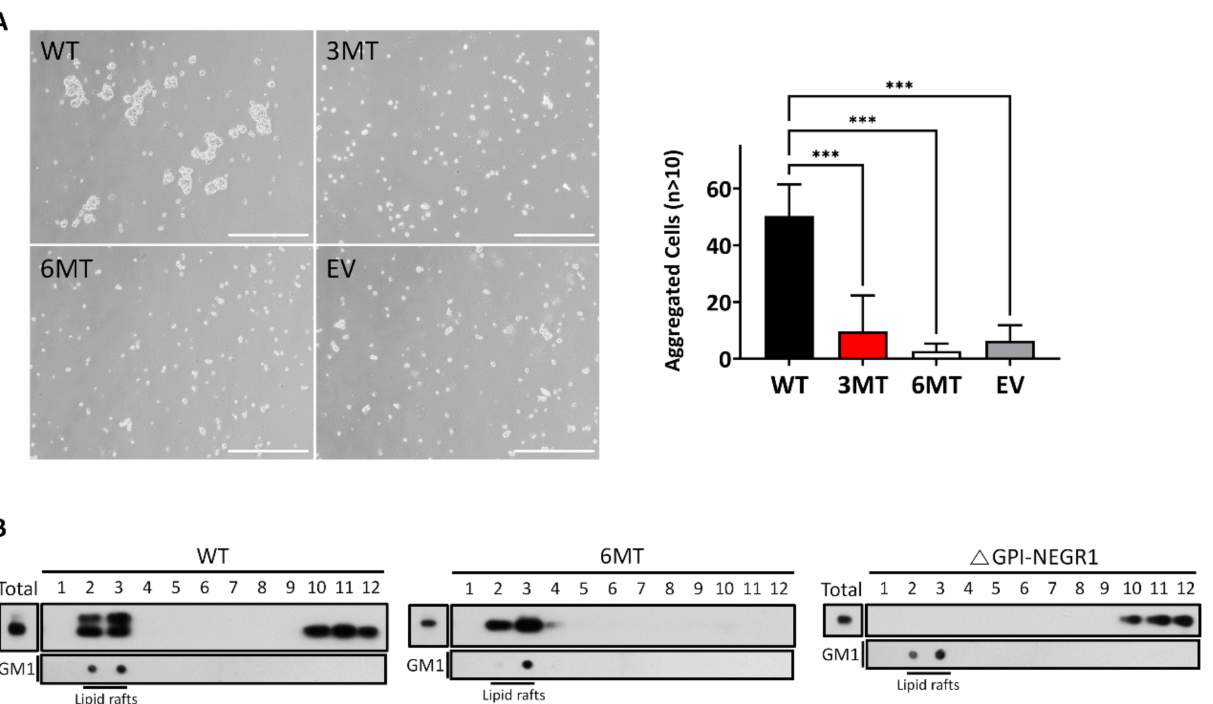
Figure 7. Hanging drop assay and lipid raft fractionation. ( A ) SKOV3 cell suspensions (3 × 10 4 in 30 µ L culture medium) were placed as hanging drops on the lid of a Petri dish and allowed to aggregate for 16 h. Cell aggregates containing more than ten cells were counted under the microscope using ImageJ software. Data are means ± standard deviation of three independent experiments. *** p < 0.001. Scale bar = 500 µ m. ( B ) After 293T cells were transfected with WT, 6MT, or a